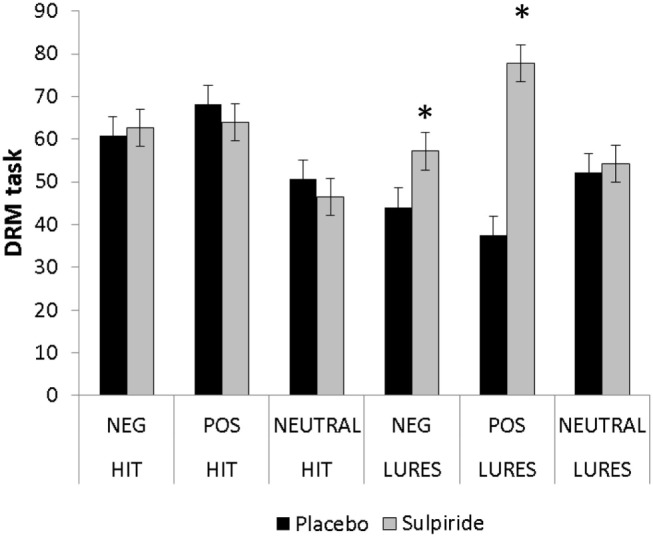
Percentage of true and false recognition in the DRM paradigm comparing the sulpiride and placebo groups. Error bars are SEMs; *p < 0.05.